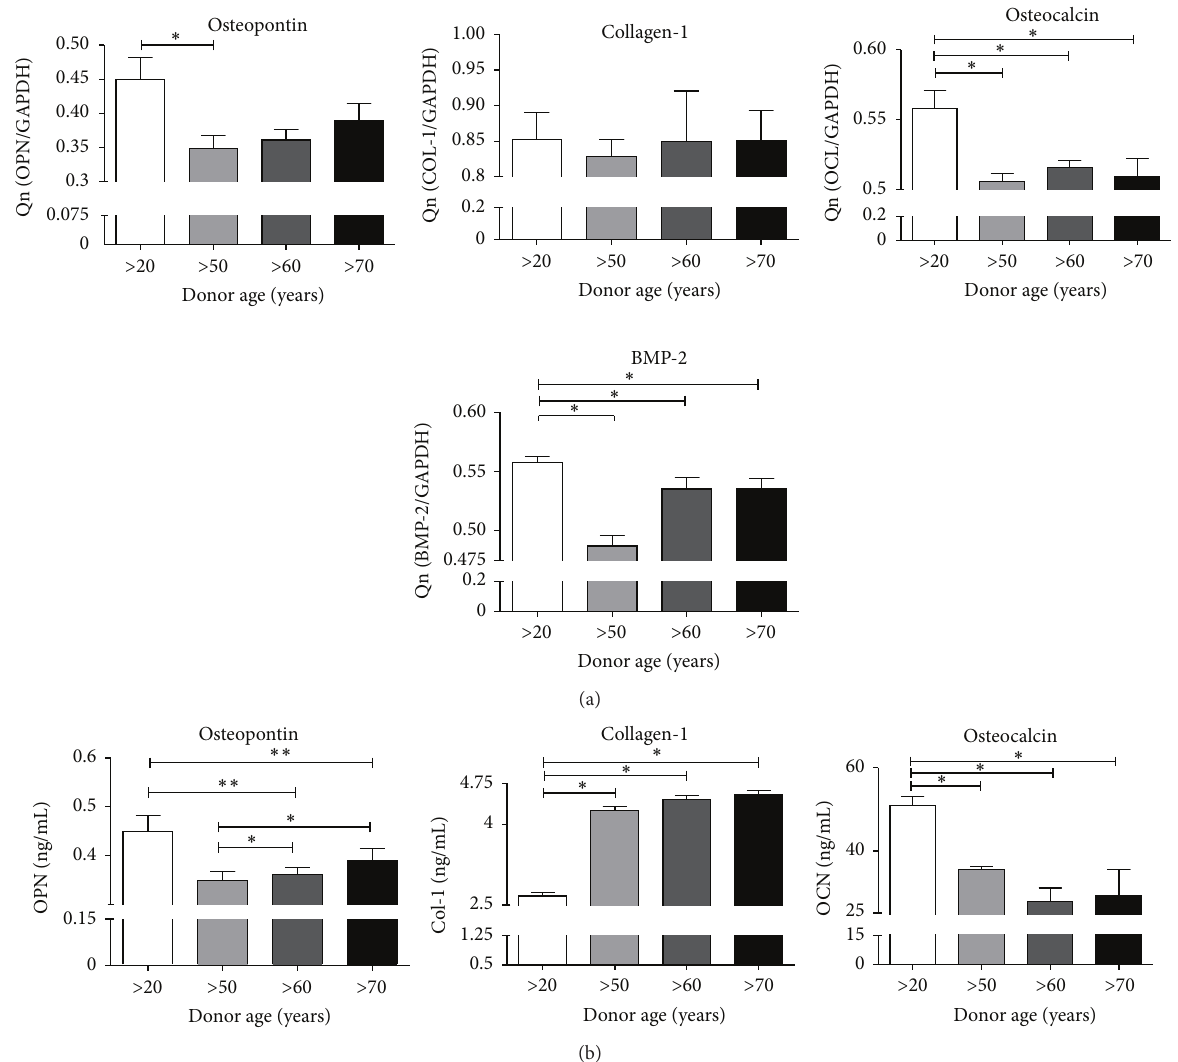
Figure 8: Gene expression and ELISA anaylsis of osteogenic markers. (a) Gene expression analysis and (b) quantitative ELISA analysis of OPN , Col-I , and OCL . Results expressed as mean ± SD. ∗ 𝑝 value <